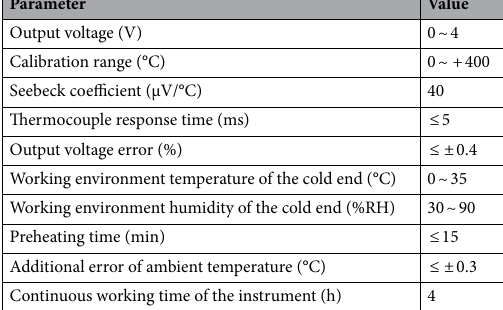
Table 2. Technical parameters of the thermocouple